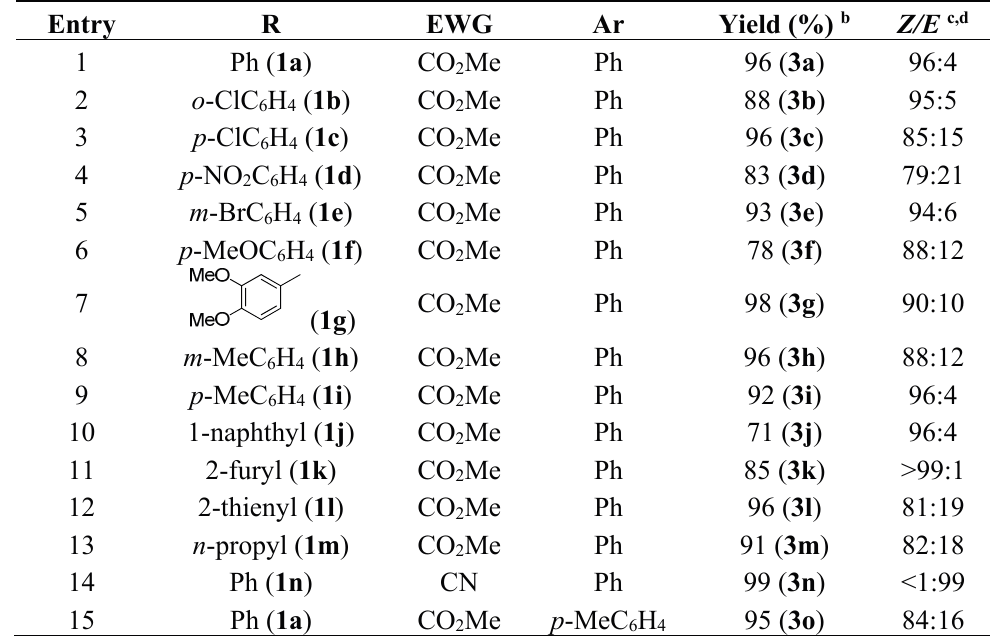
Table 2. Substrate scope for allylic sulfonylation of MBH carbonates 1 with sodium sulfinates 2 a